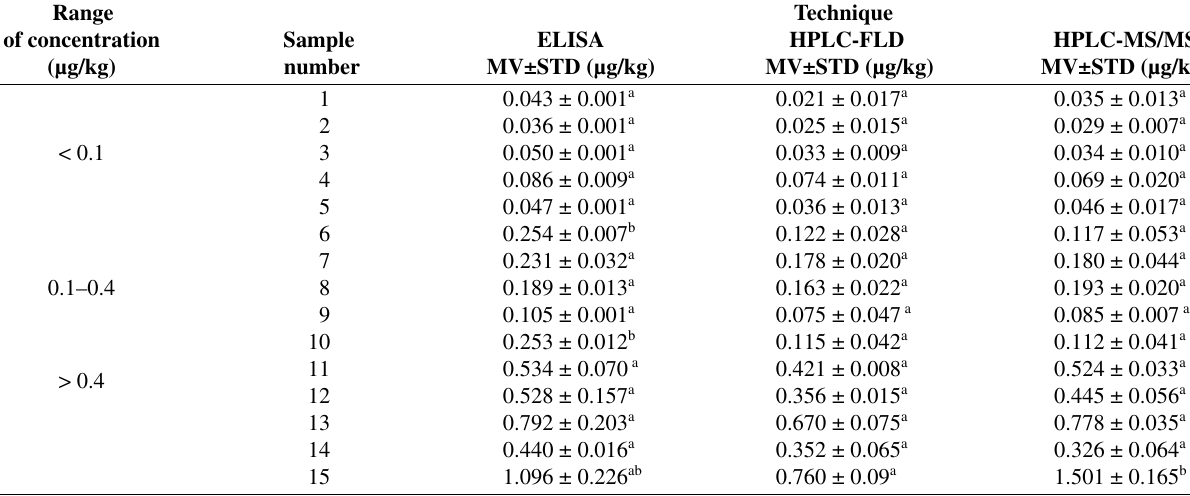
Table 3 . Content of AFM1 determined by ELISA, HPLC and LC-MS/MS techniques Range Technique